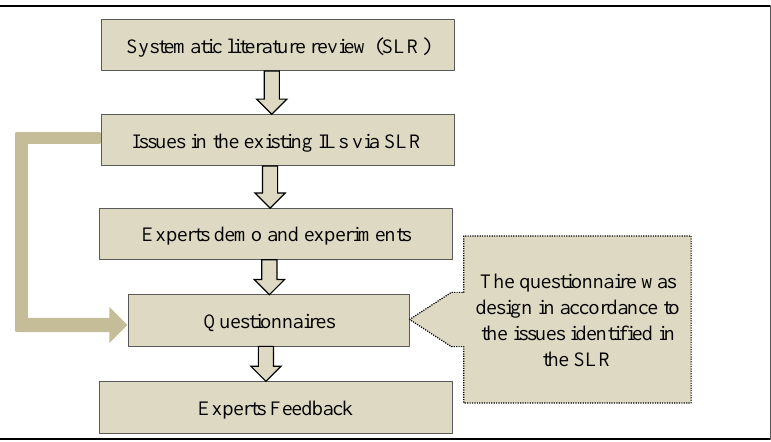
Figure 3. Different phases of our study and their